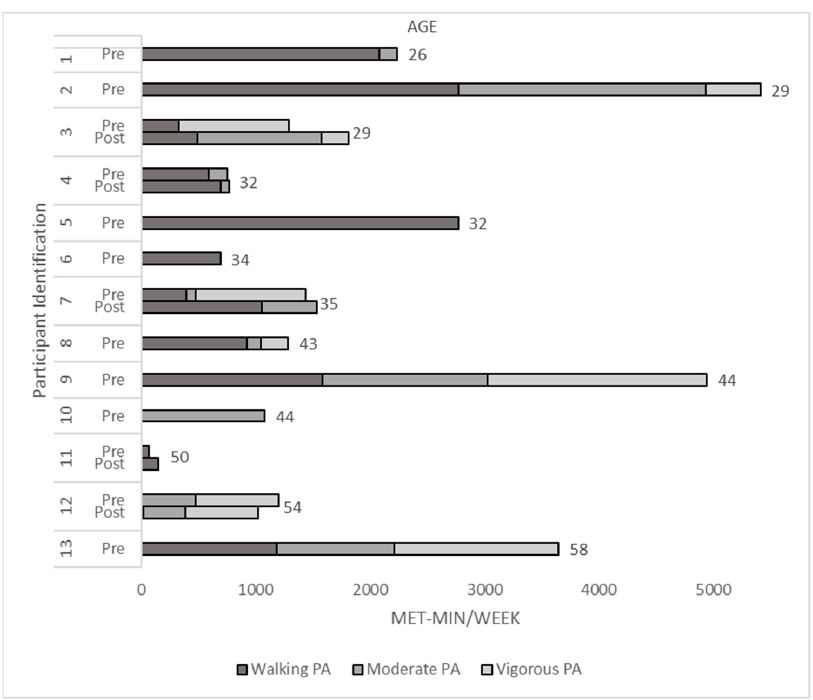
Figure 2. The 7-Day Physical Activity in MET-min/week of Adults Reported by the International Physical Activity Questionnaire. Physical Activity